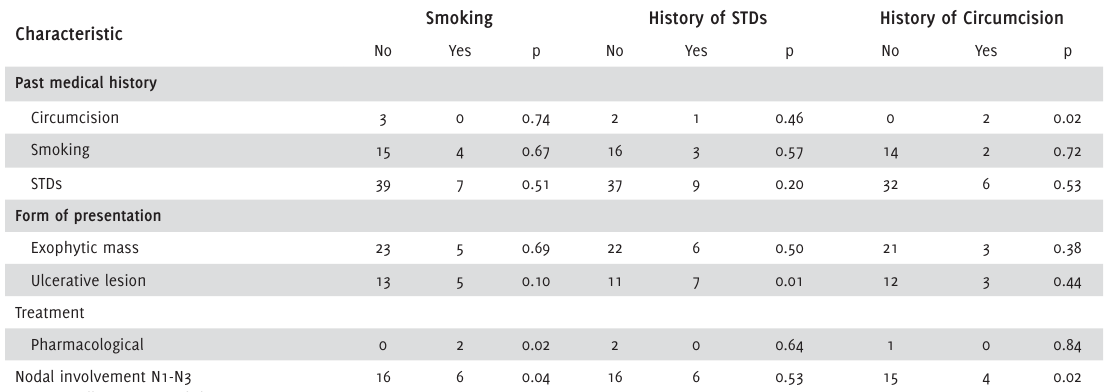
Table 2. Relationship between Clinical Variables and Outcomes in Patients with Penile Cancer Diagnosis in a Tertiary Referral Hospital in Cali, Colombia, 2001-2010.